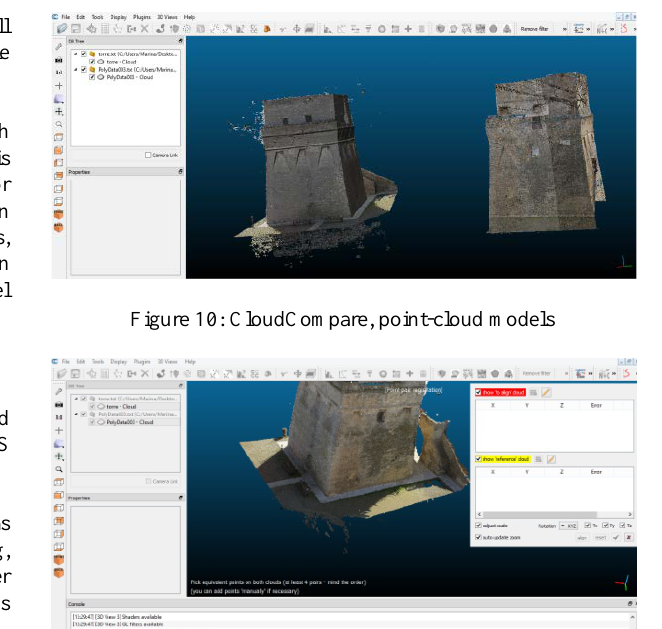
cloud, align and show the cloud/cloud distances, also obtaining a colour scalar field as a result of the difference analysis.